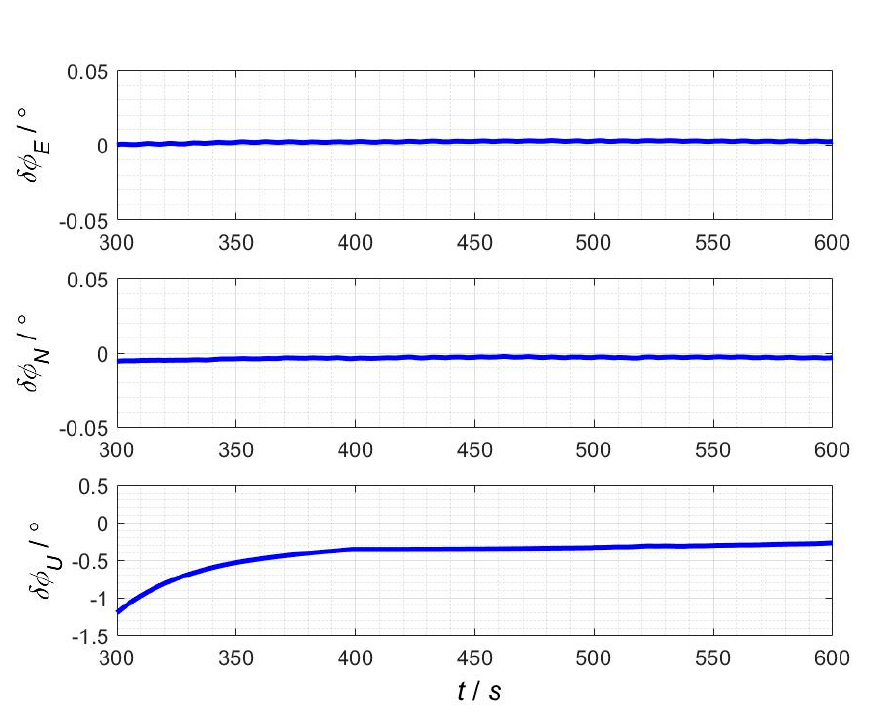
Figure 6. The alignment errors on swaying base and steady-state enlarged curves. ( a ) The alignment errors from 0 s to 600 s; ( b ) the corresponding steady-state enlarged curves from 300 s to 600 s.